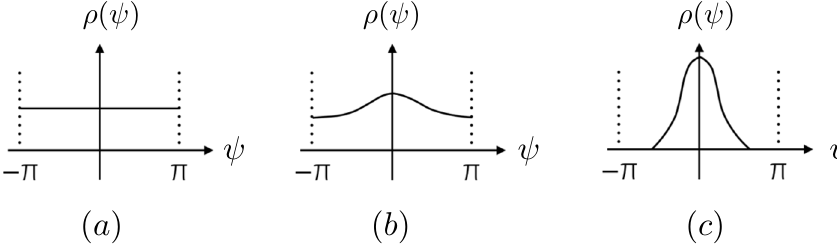
Figure 1. Schematic depictions of the eigenvalue distributions, ρ ( ψ ) , of the path-ordered